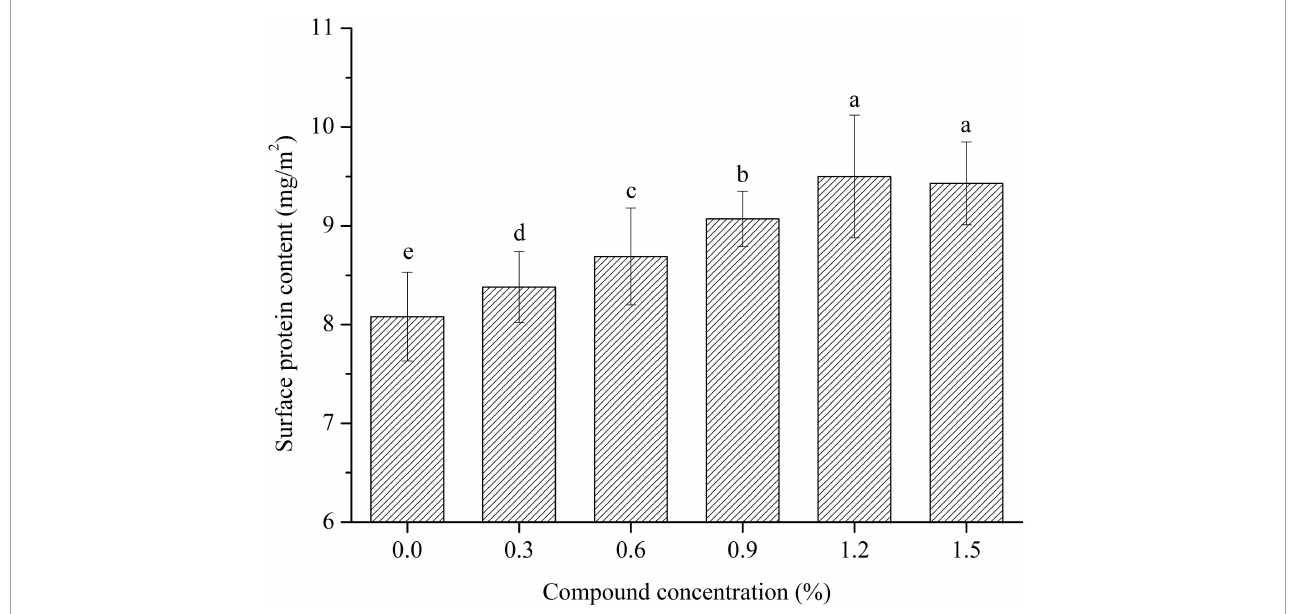
FIGURE8 The surface protein content of the emulsions with different concentrations of compound